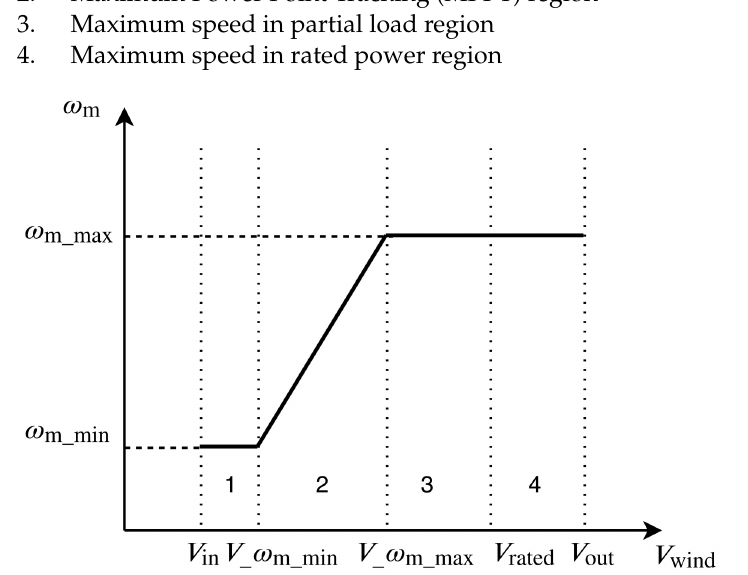
Figure 6. Speed curve based on four speed